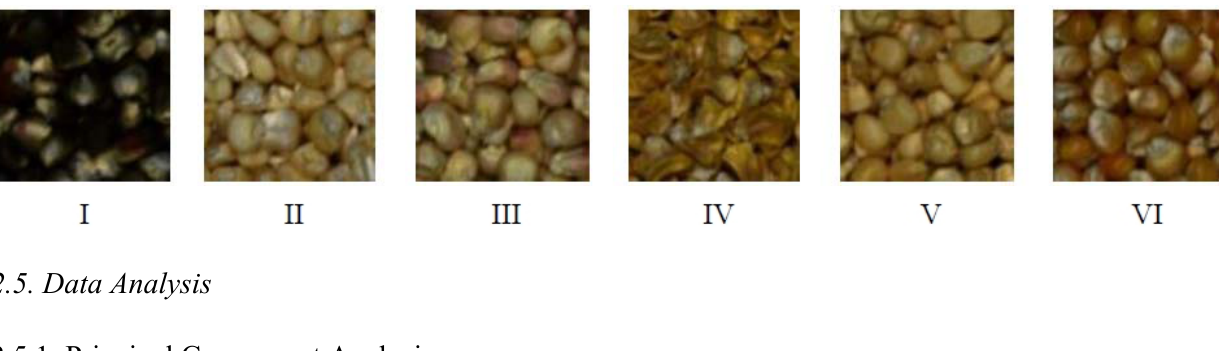
Figure 2. Images acquired from six varieties of maize